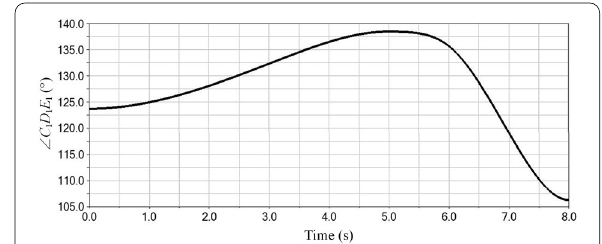
Figure 28 The simulation value of ∠ C 1 D 1 E 1 when the mechanism avoids singular position